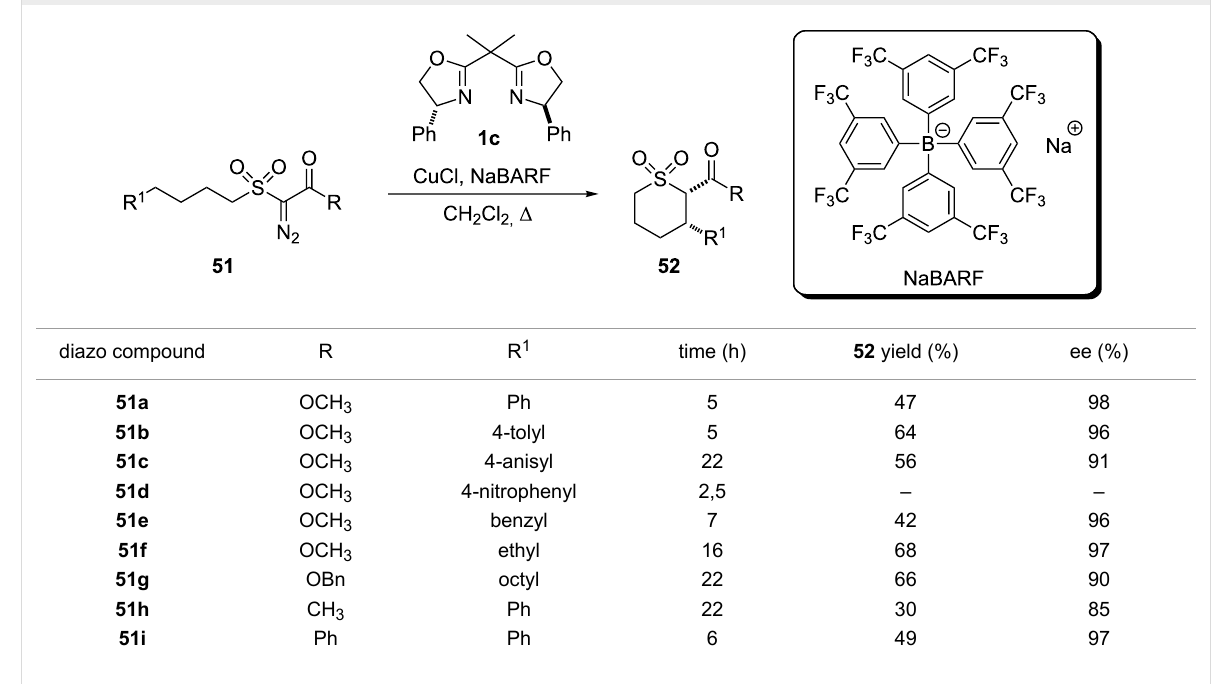
Table 5: Insertion of asymmetric copper carbenoid C(sp 3 )–H bonds to prepare thiopyrans 52 .